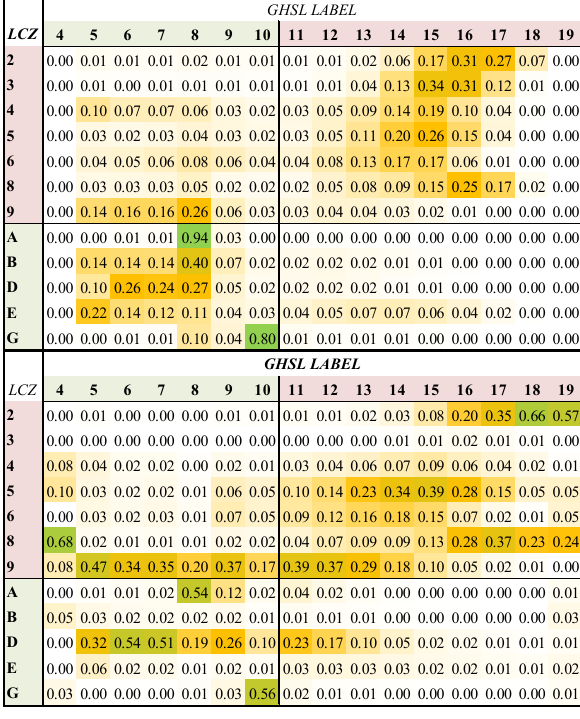
Table 4. Contingency table between LABEL (columns) and LCZ (rows) for Milan (derived at higher resolution). Upper: weighted by LCZ occurrence; lower: weighted by LABEL occurrence. Red and green symbolize built and natural classes